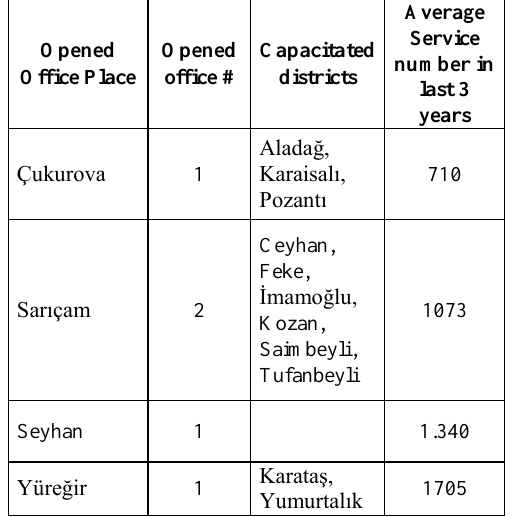
Table 3. LOSC offices in Adana. (Approval of GDLRC, 2014) 4. EXPERIENCES IN